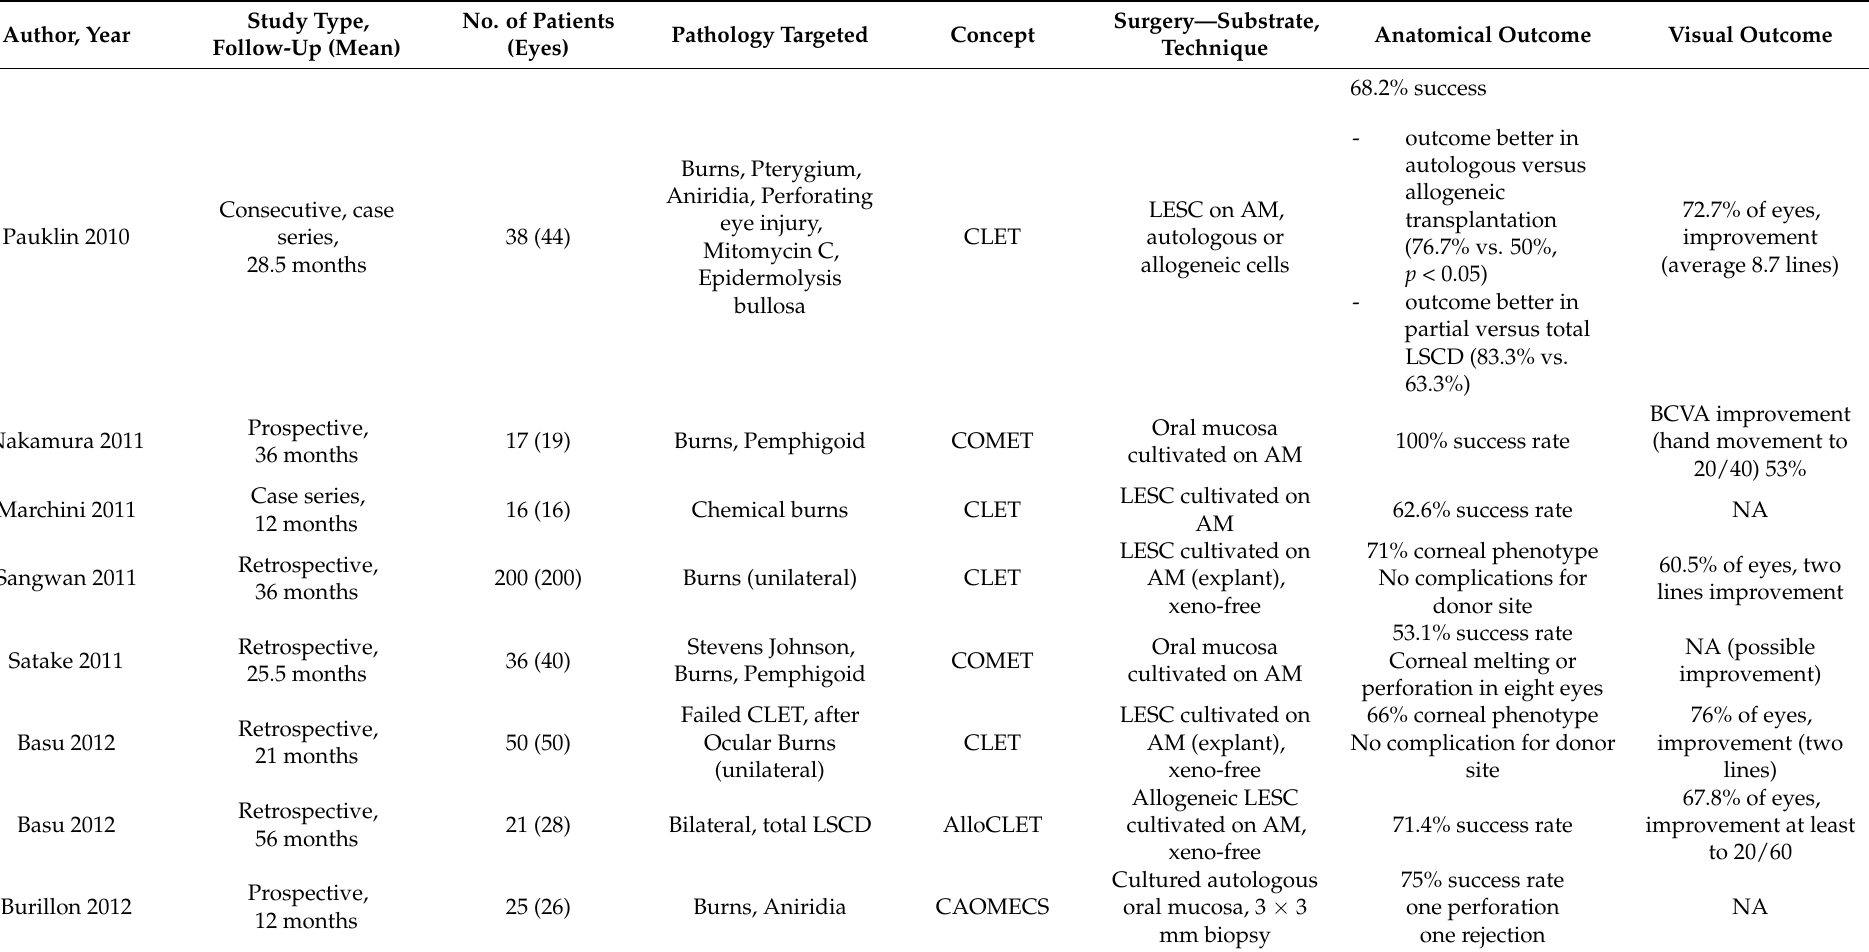
Table 1. Summary of studies involving corneal reconstruction. Study concept and outcome (anatomical and